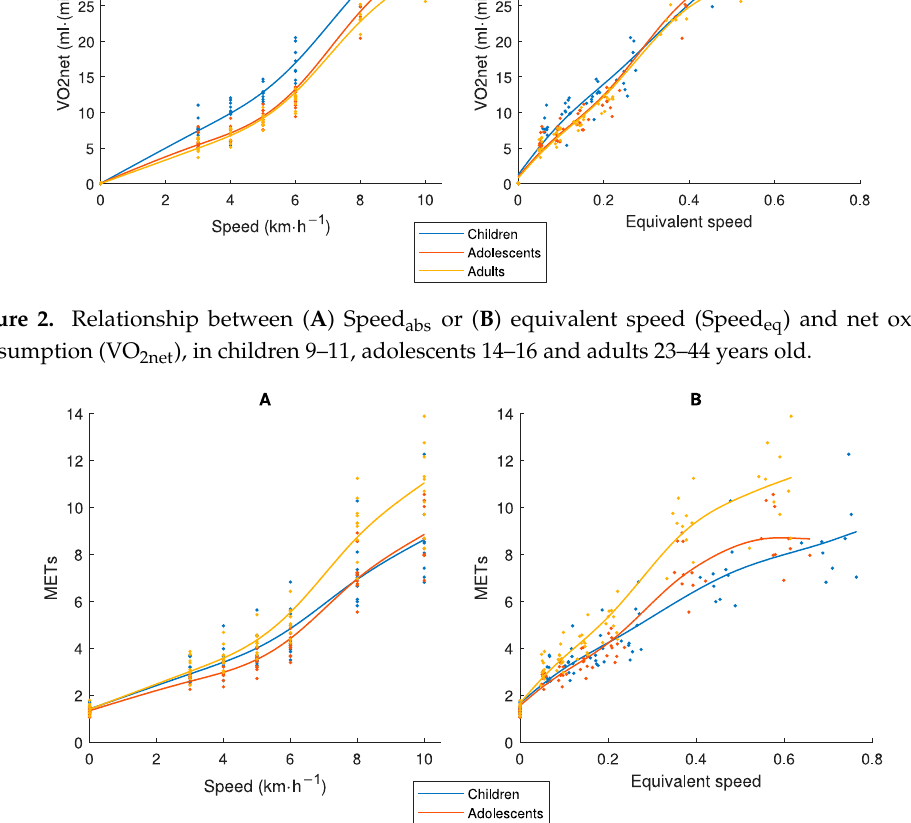
Figure 3. Relationship between ( A ) Speed abs or ( B ) Speed eq and Metabolic Equivalent of Task (MET), in children 9–11, adolescents 14–16 and adults 23–44 years old.